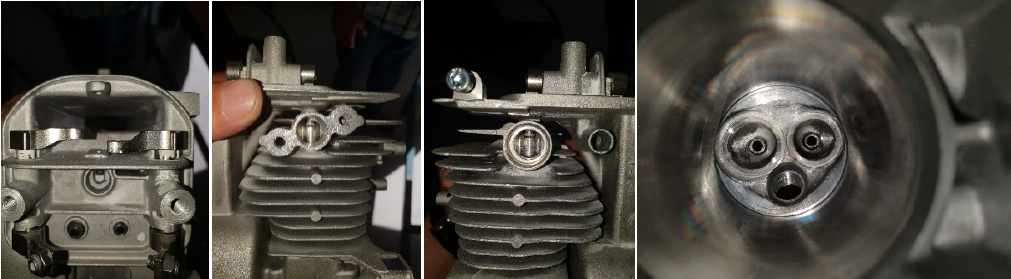
Figure 13. Modification of valve tappets, intake/exhaust duct and combustion chamber.